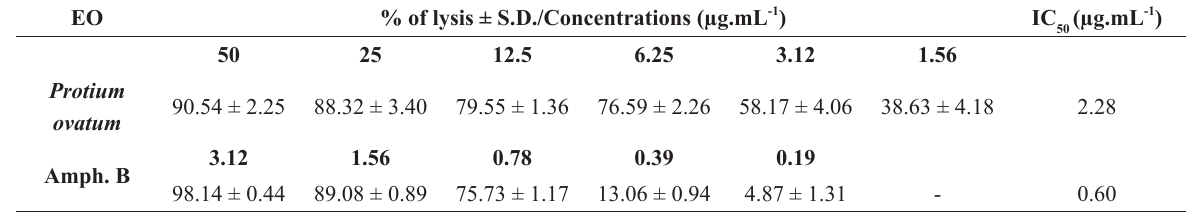
Leishmanicidal activity of essential oil from P. ovatum leaves.